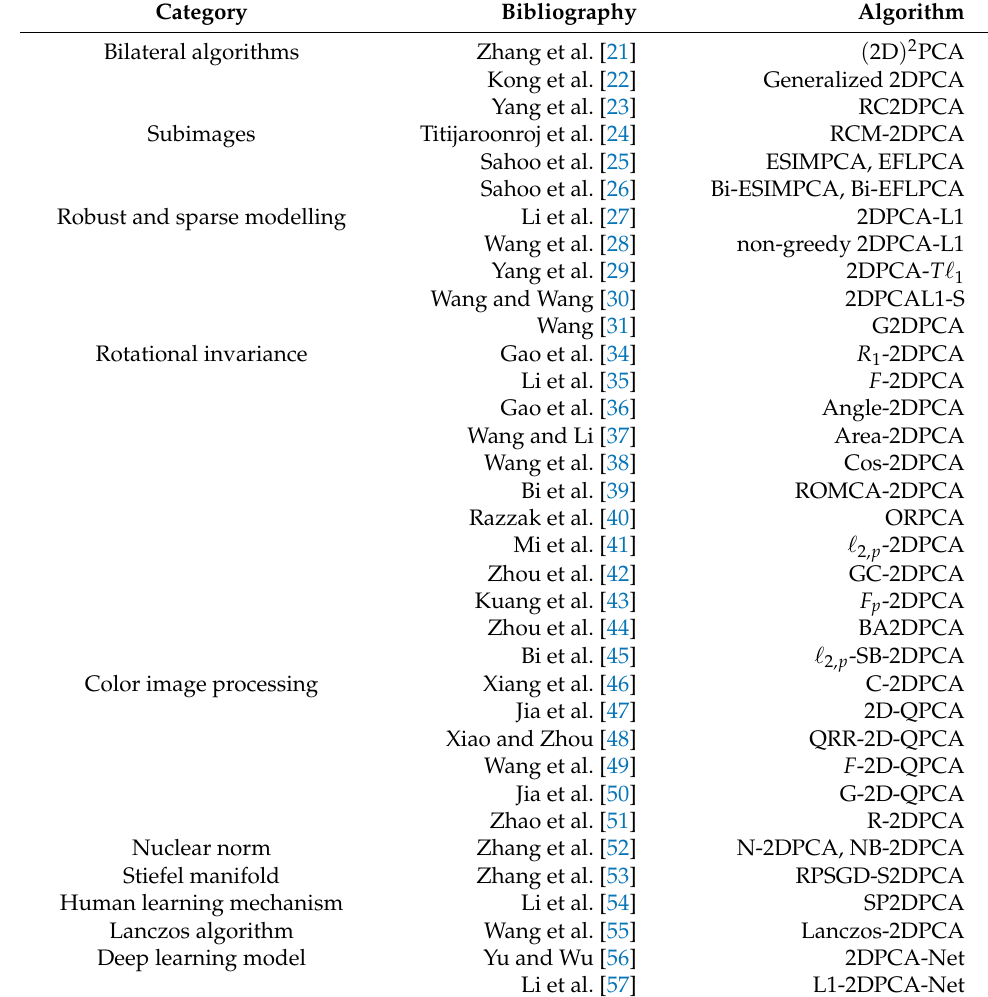
Table 1. Recent advances of